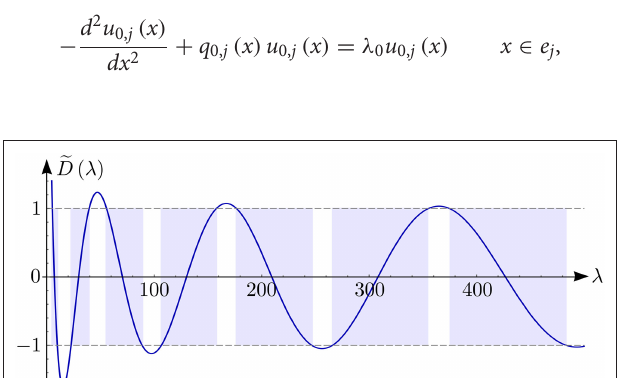
D (λ) for the Kronig-Penney e